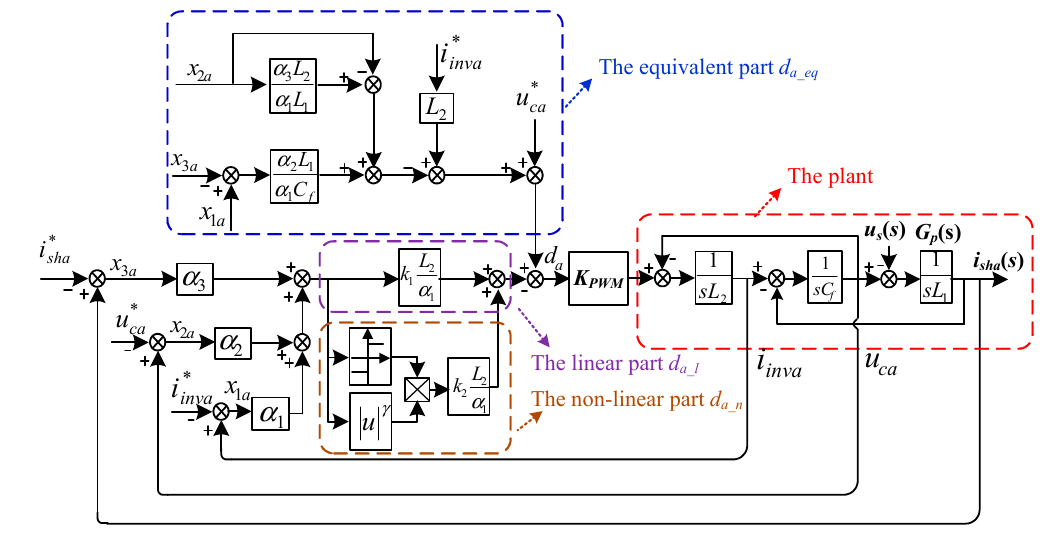
Figure 2. A-phase control block diagram of SAPF based on sliding mode control (SMC).